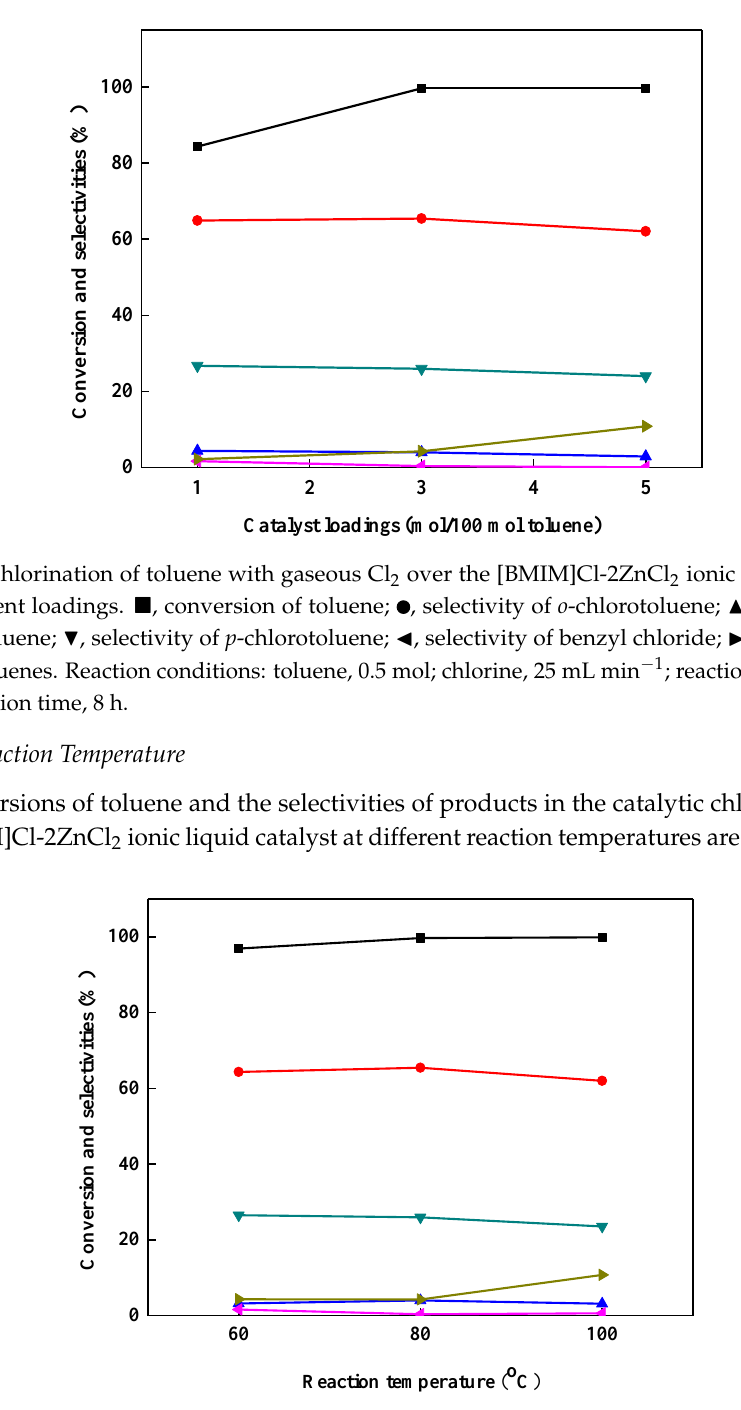
Figure 4. Chlorination of toluene with gaseous Cl 2 over the [BMIM]Cl-2ZnCl 2 ionic liquid catalyst at different reaction temperatures. ■ , conversion of toluene; ●, selectivity of o -chlorotoluene; ▲ , selectivity of m -chlorotoluene; (cid:72) , selectivity of p -chlorotoluene; (cid:74) , selectivity of benzyl chloride; (cid:73) , selectivity of dichlorotoluenes. Reaction conditions: toluene, 0.5 mol; chlorine, 25 mL min − 1 ; [BMIM]Cl-2ZnCl 2 , 3 mol/100 mol toluene; reaction time, 8